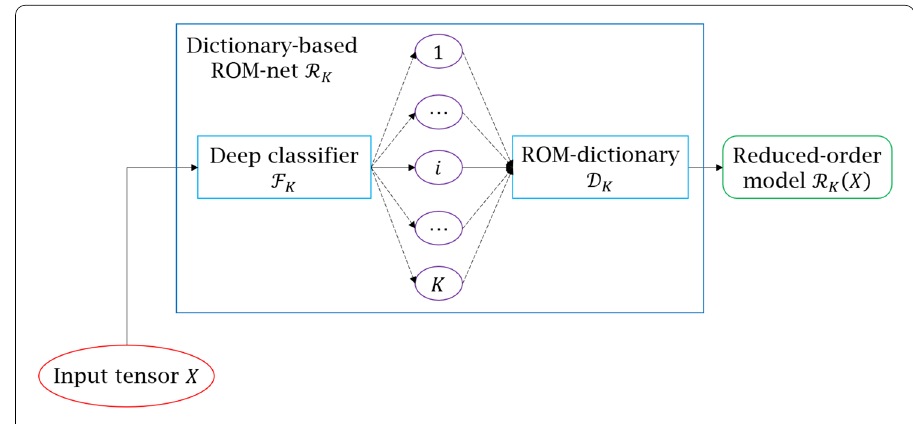
Fig. 2 Flowchart of a dictionary-based